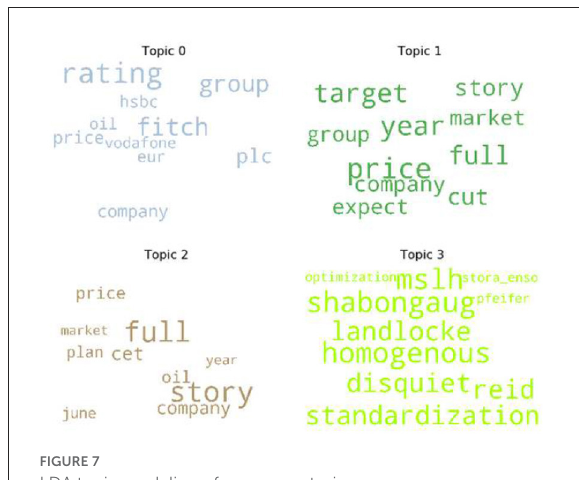
FIGURE7 LDA topic modeling of our news stories corpus.